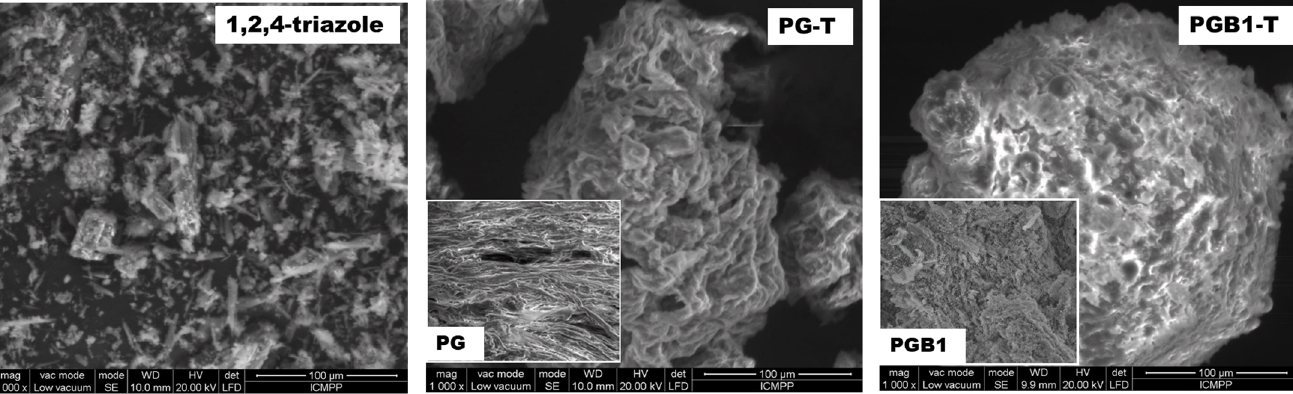
Figure 10. XRD patterns of 1,2,4-triazole, PG-T, and PGB1-T systems ( a ) and of PG and PGB1 copolymers ( b )